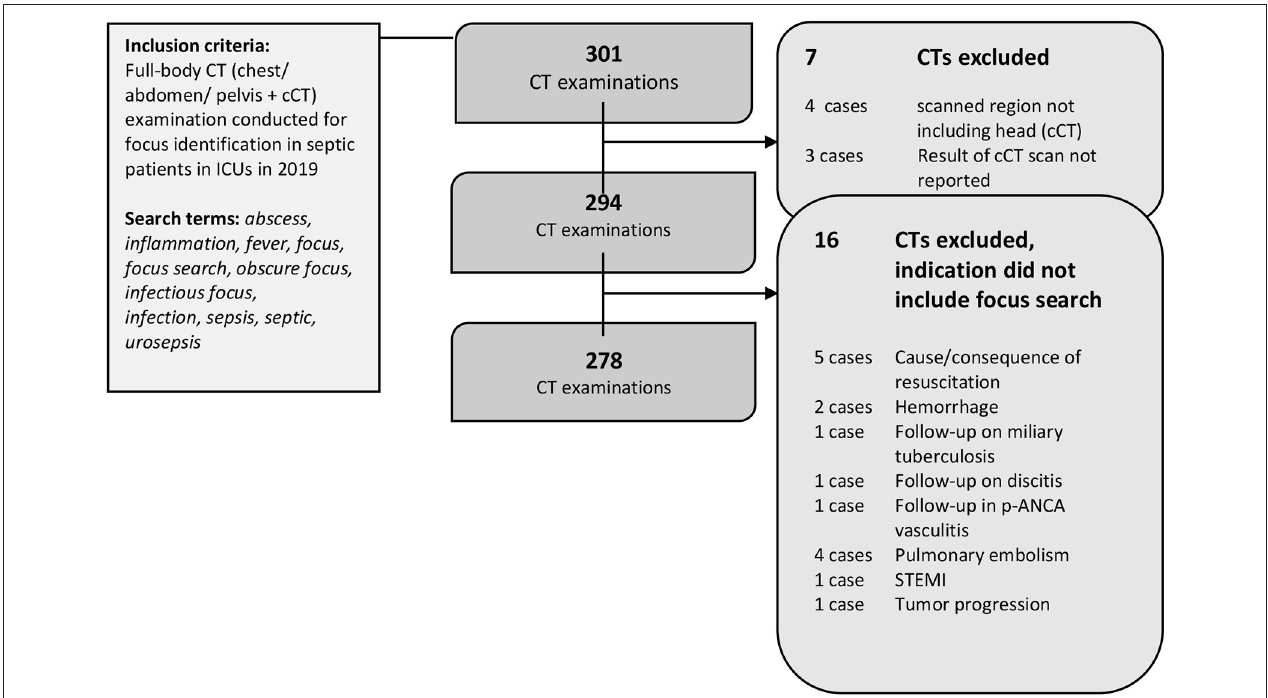
FIGURE 1 | Patient flow. 301 CT reports were identified by the full-text search. Seven CTs were excluded as the required organ regions were not fully examined. Another 16 CTs were excluded after the analysis due to indications other than focus search. A final 278 CT reports were included in the